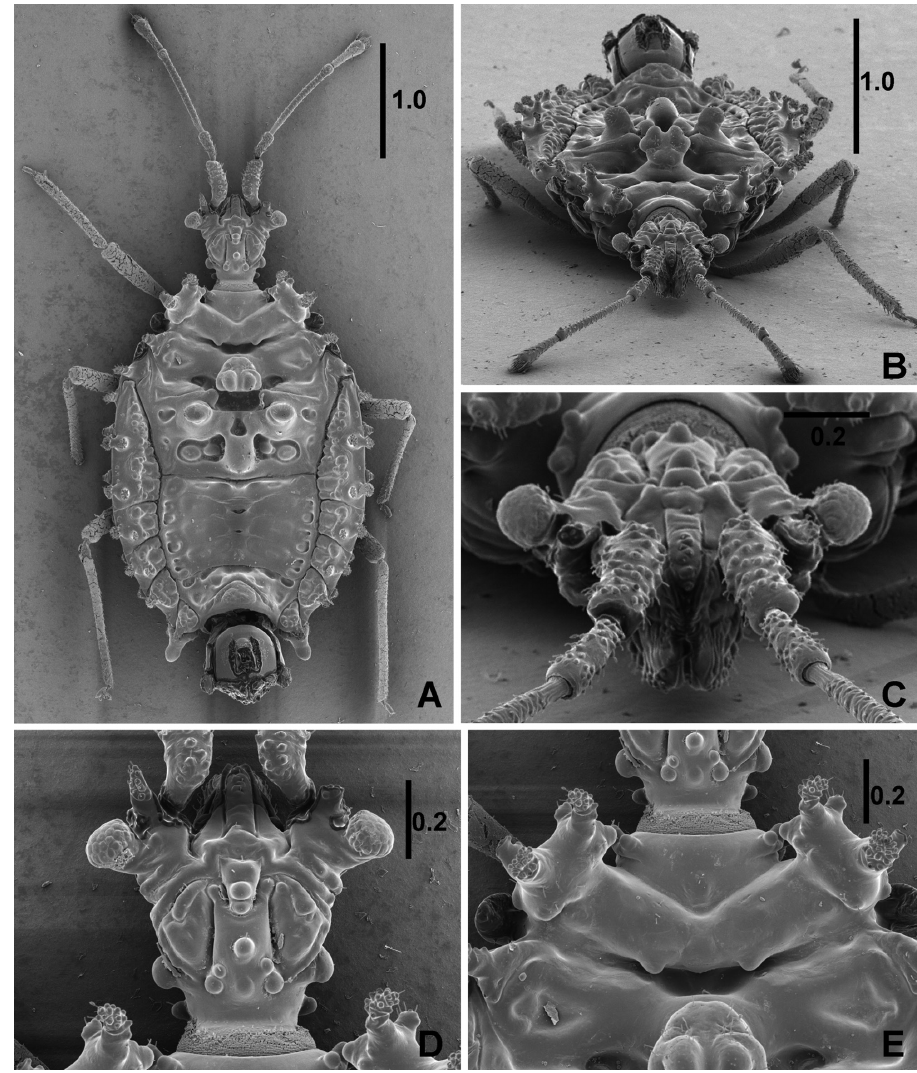
Figure 2. Cervinotaptera tomhenryi sp. n., male paratype, scanning electron micrographs. A dorsal habi- tus B dorsal habitus, anterior view C head, anterior view D head, dorsal view E pronotum, dorsal view. Scale bars in